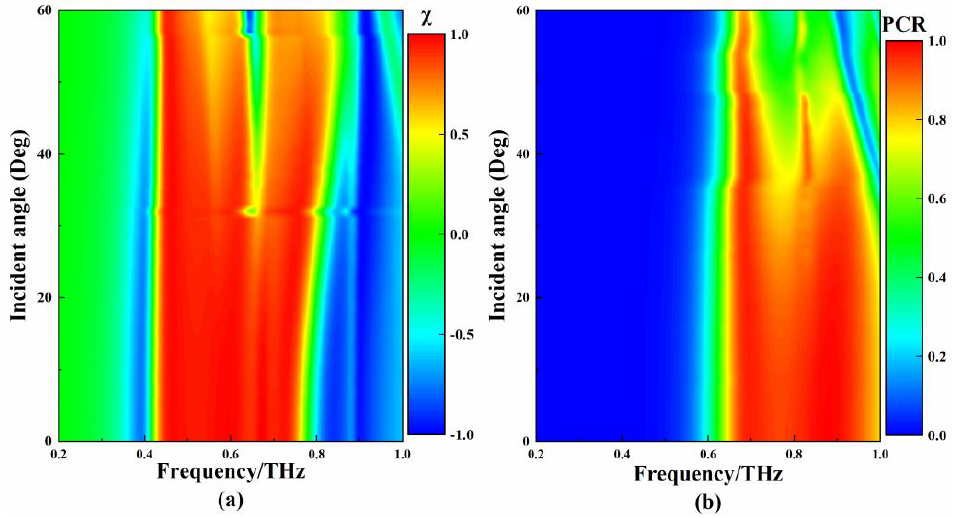
Figure 10. ( a ) Ellipticity corresponding to different incident angles of THz waves; ( b ) PCR corre- sponding to different incident angles of THz waves.